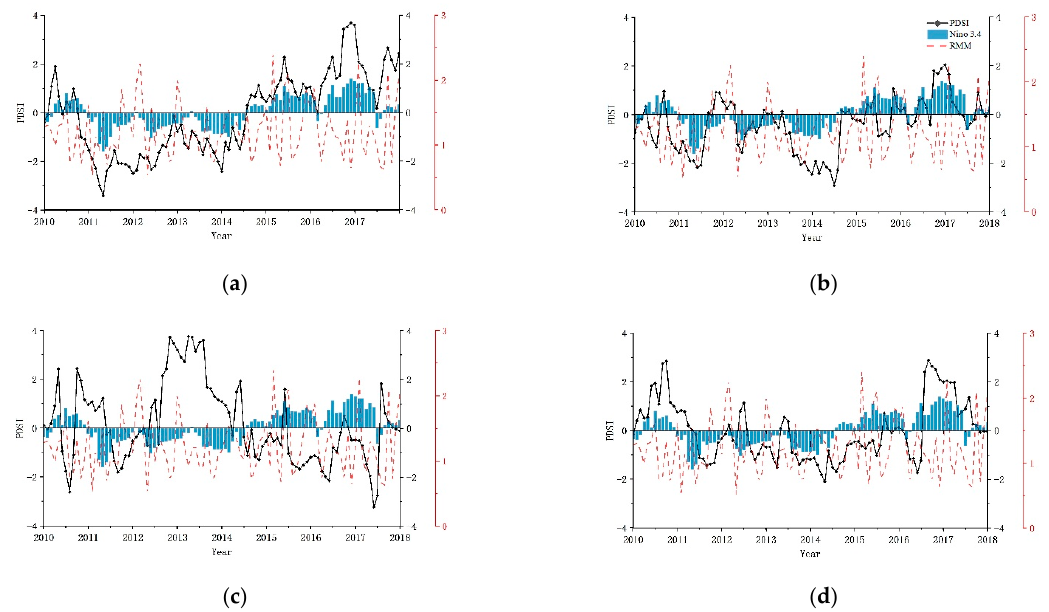
Figure 7. Time series of PDSI with ENSO and MJO: ( a ) south of the Huaihe River and the middle and lower reaches of the Yangtze River; ( b ) North China Plain; ( c ) Southwest Songliao Plain; and ( d ) Tarim and Turpan basins.